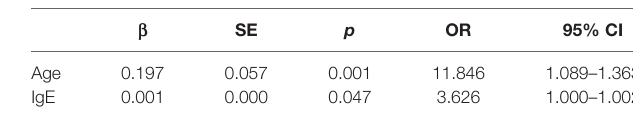
TABLE 4 | Logistic regression analysis of complications in children with MPP.